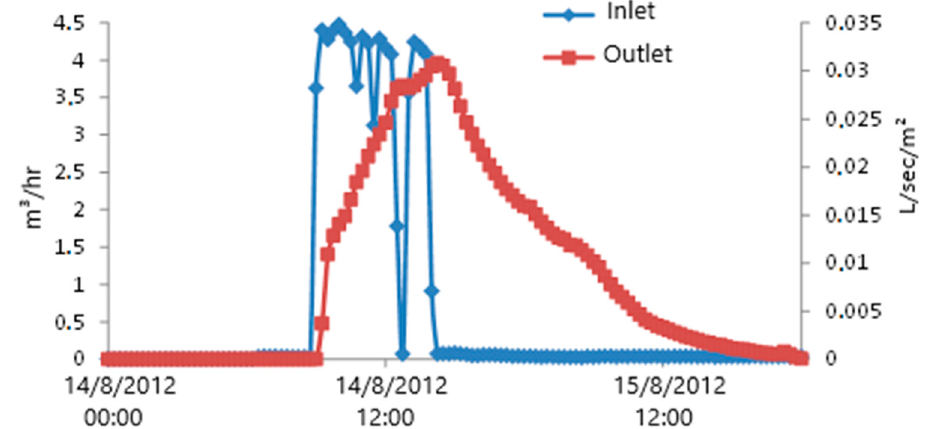
Figure 13. Pilot STRB at Hanningfield WW: four sludge loads during the same day (blue curve, m³/h) and the dewatering profile (red curve, L/s/m²) [53].